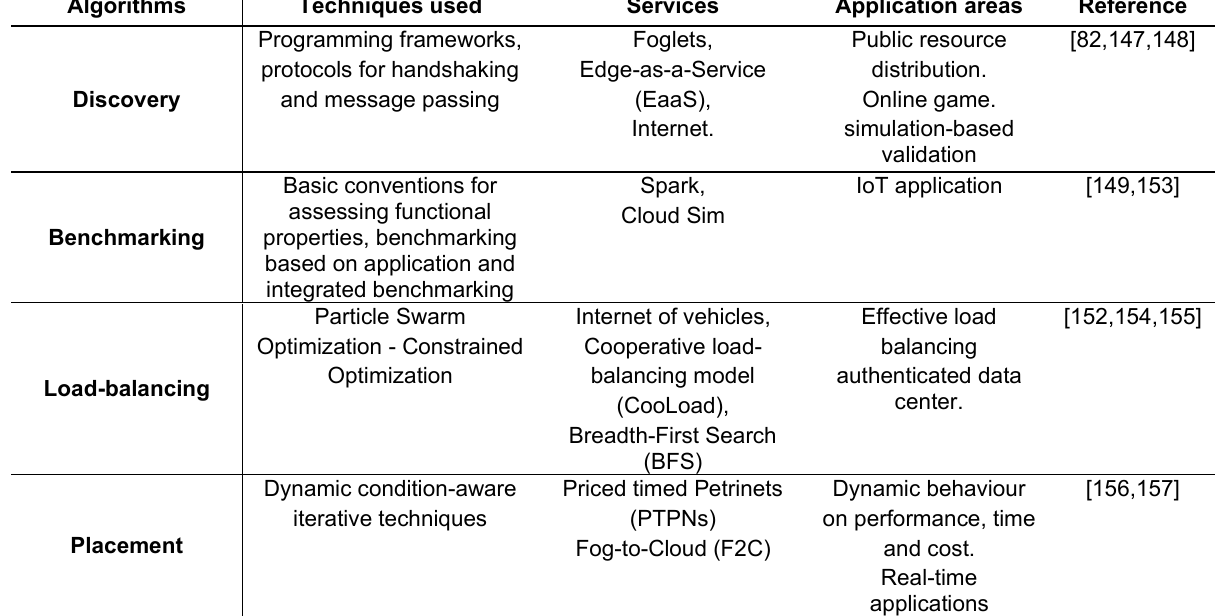
Table 6. Types of